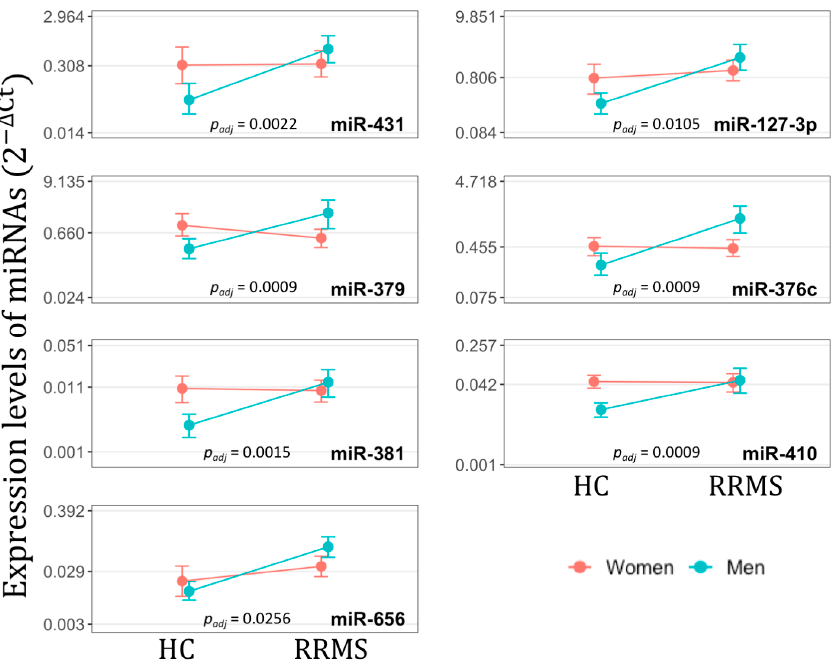
Figure 2. Interaction plots for expression levels (2 − ∆ Ct ) of miR-431, miR-127-3p, miR-379, miR-376c, miR-381, miR-410 and miR-656 according to “health–disease” status and gender of individuals, as determined by RT- q PCR. Mean (2 − ∆ Ct ) values were calculated for healthy controls (HC), i.e., healthy men and healthy women, and for relapsing-remitting multiple sclerosis (RRMS) patients, i.e., RRMS men and RRMS women. The intersection of lines on the plot suggests that there is an interaction effect between “health–disease” status and gender, what is confirmed by the significant p adj values.